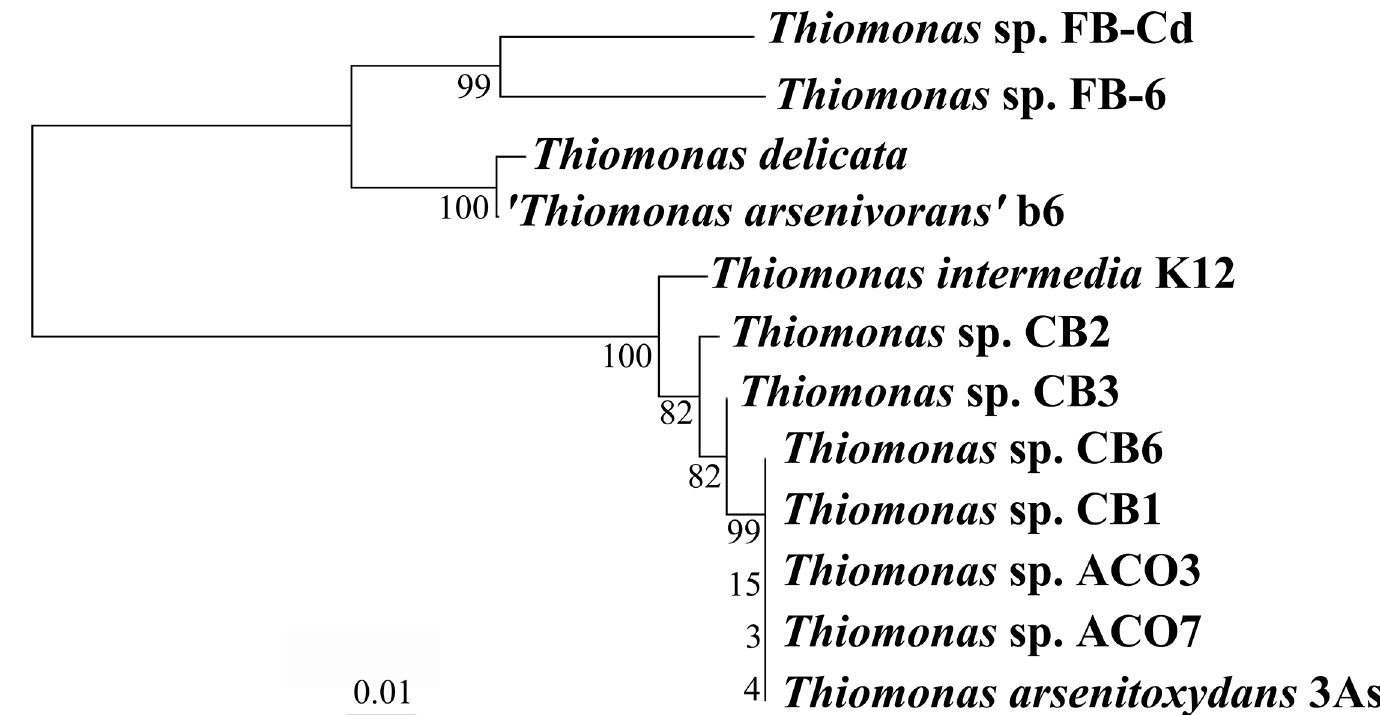
Fig 1. Maximum likelihood tree of the Thiomonas strains included in this study. The tree is based on the concatenated alignment of rpoA , dnaK , atpD , 16S rDNA, and 23S rDNA genes (8628 nucleotide positions). The sequences were aligned with the MUSCLE and trimmed with GBLOCKS programs implemented in SEAVIEW software version 4.5.4 [46] and then concatenated. The tree was inferred with PhyML version 3.1 [47], using the GTR+ Γ 4 model as suggested by the proposed model tool implemented in TREEFINDER v2011 [48], using the NNI+SPR option for topology search. Values at branch nodes correspond to bootstrap values (100 replicates) calculated with PhyML and to posterior probabilities calculated with MrBayes version 3.2.2 [49], with the GTR + G4 model. The scale bar represents the average number of substitutions per site.